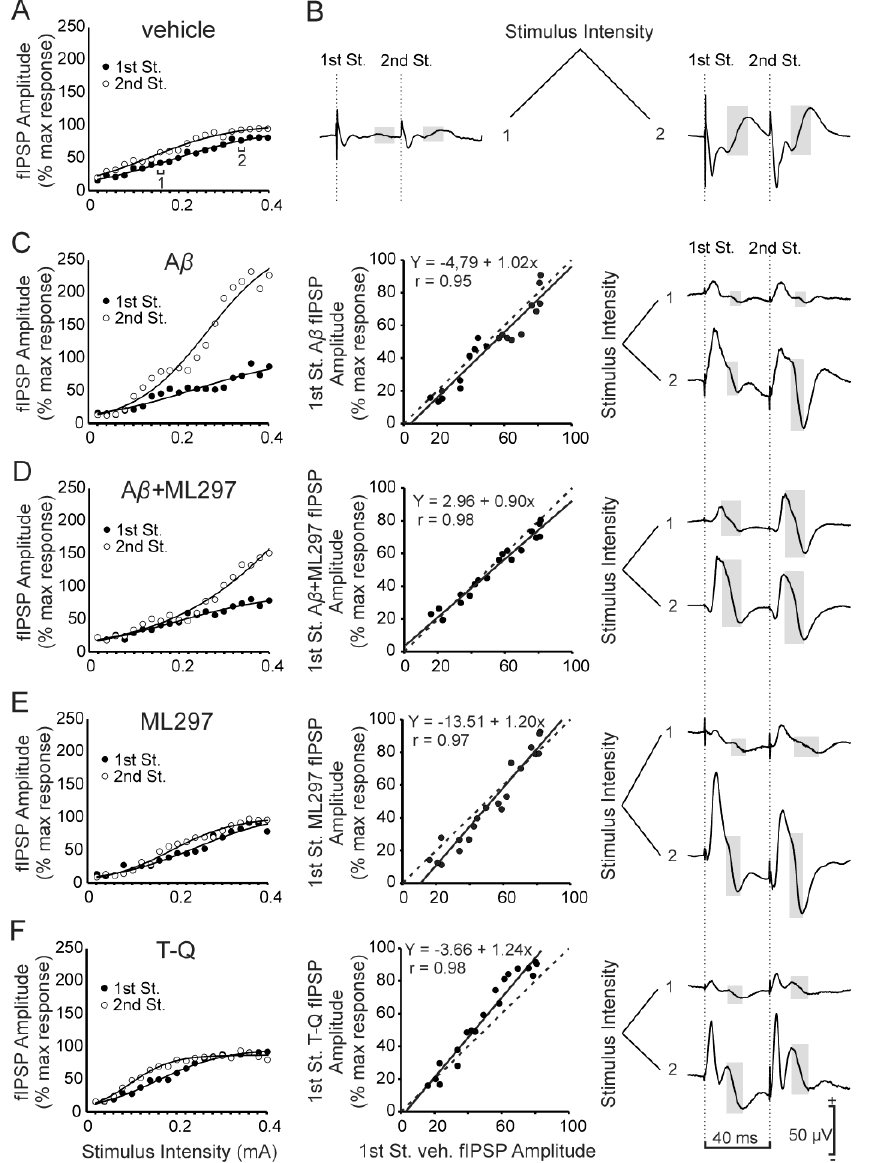
slope close to 1 (b = 1.02, p < 0.001), so the evolution of the response to the 1st stimulus is not altered by the effect of A β in comparison to controls (vehicle-injected mice). Overall, the results indicate that these animals show an increase in the inhibitory tone.